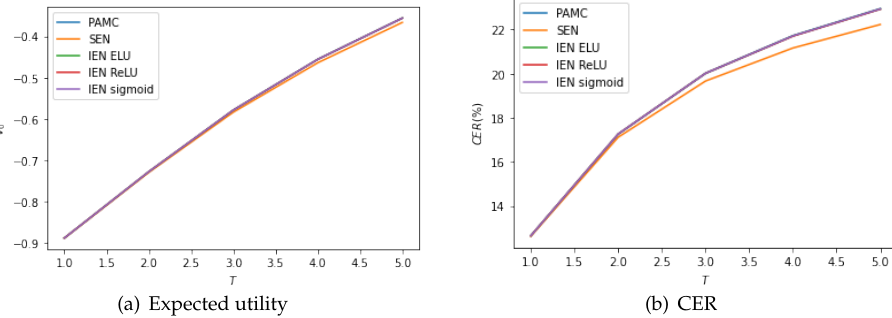
Figure 6. S t follows the OU 4/2 model, where ( a ) shows the expected utilities obtained via approxi- mation methods versus investment horizon T ; and ( b ) shows the CERs versus investment horizon T given γ =